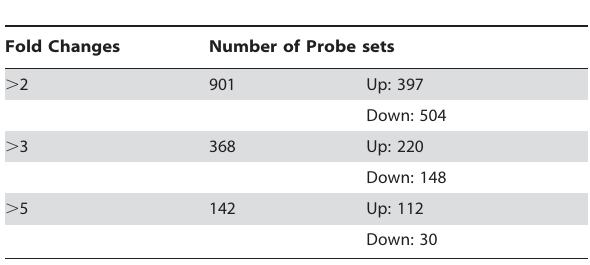
Table 1. Statistics for microarray with a p value ,